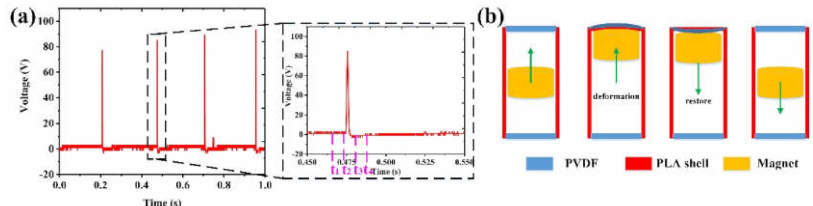
Figure 5. The output characteristics of the PEG unit. ( a ) The output voltage corresponding to different stages within one cycle. ( b ) Magnet movement and PVDF status in different stages.